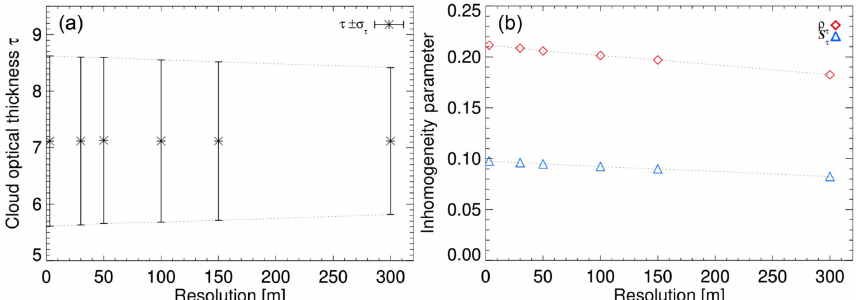
Figure 6. Comparison of (a) mean and standard deviation and (b) inhomogeneity parameters ( ρ and S ) as a function of spatial resolution for the fields of τ meas illustrated in Fig.